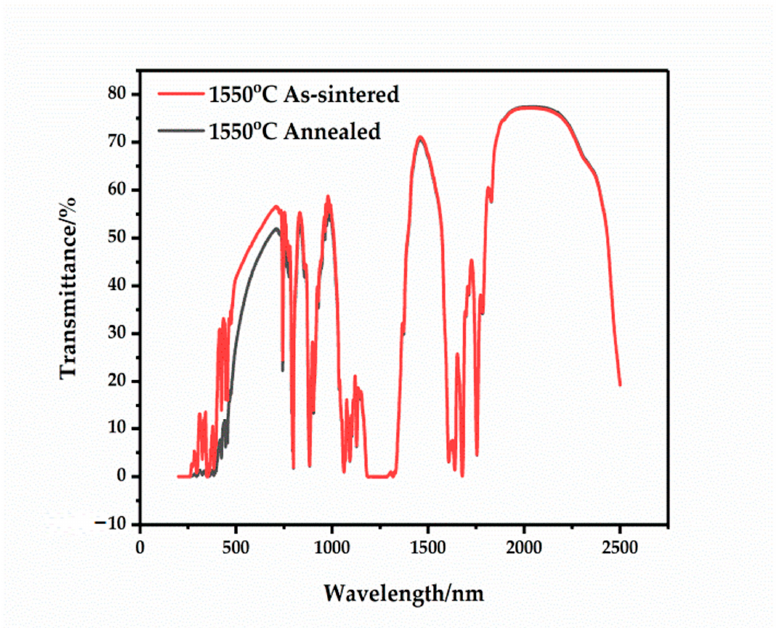
Figure 4. Transmittance curves of the (Dy 0.7 Y 0.25 La 0.05 ) 2 O 3 ceramics: as-sintered and additionally annealed at 900 °C for 5 h in air.